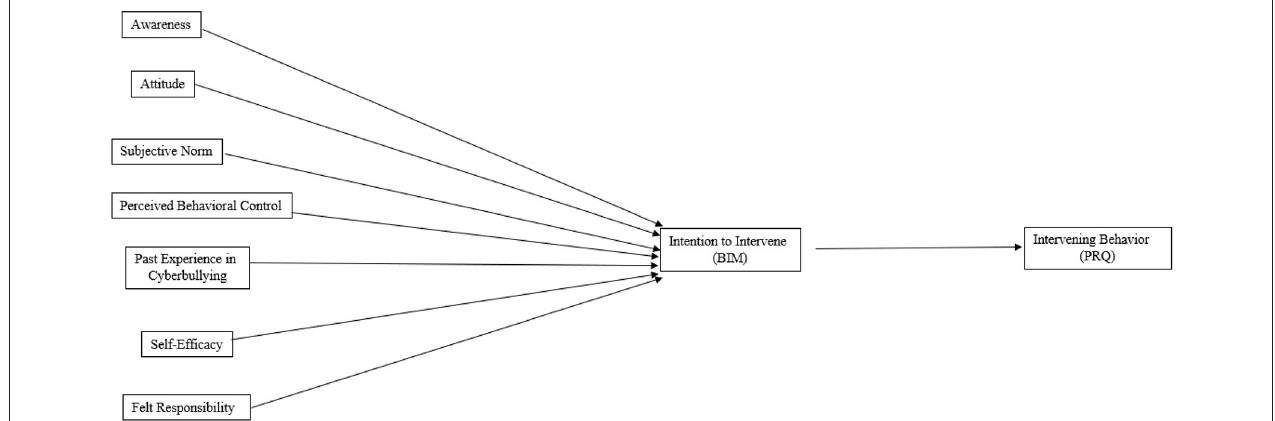
FIGURE 1 | Proposed conceptual model of the preregistered hypotheses. For simplicity, controlled variables (age and gender) and concurrent relations among predictors are not shown in the conceptual model. Past experience in cyberbullying was measured as “experience in cyberbullying victimization” and “experience in cyberbullying victimization”